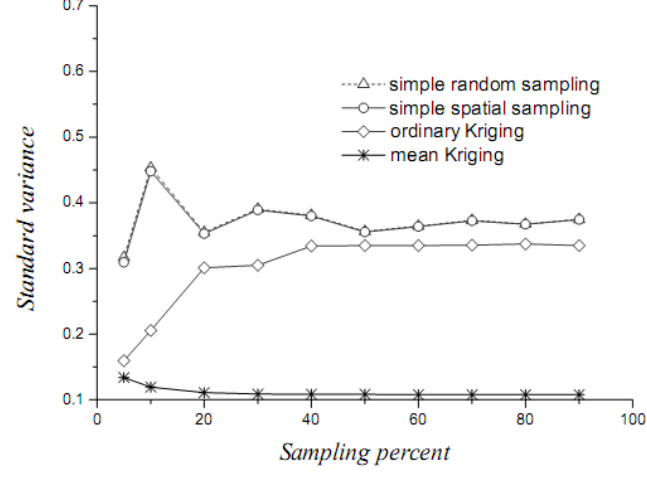
Figure 11. Standard variances of the estimated cultivated land proportion by the three techniques.